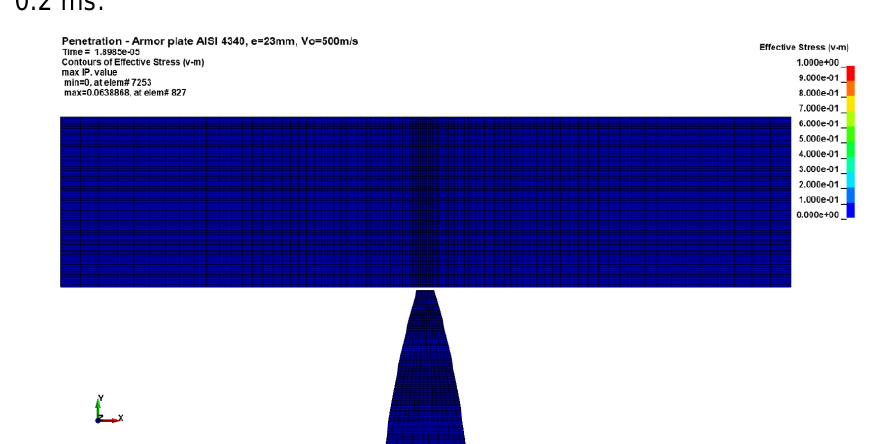
Figure 10 – Von Misses equivalent stress, time of analysis 0.01 ms – Model 2 Рис. 10 – Von Misses эквивалентное напряжение, время анализа 0.01 ms – Модель 2 Слика 10 – Von Misses-ов еквивалентни напон, време анализе 0,01 ms – модел